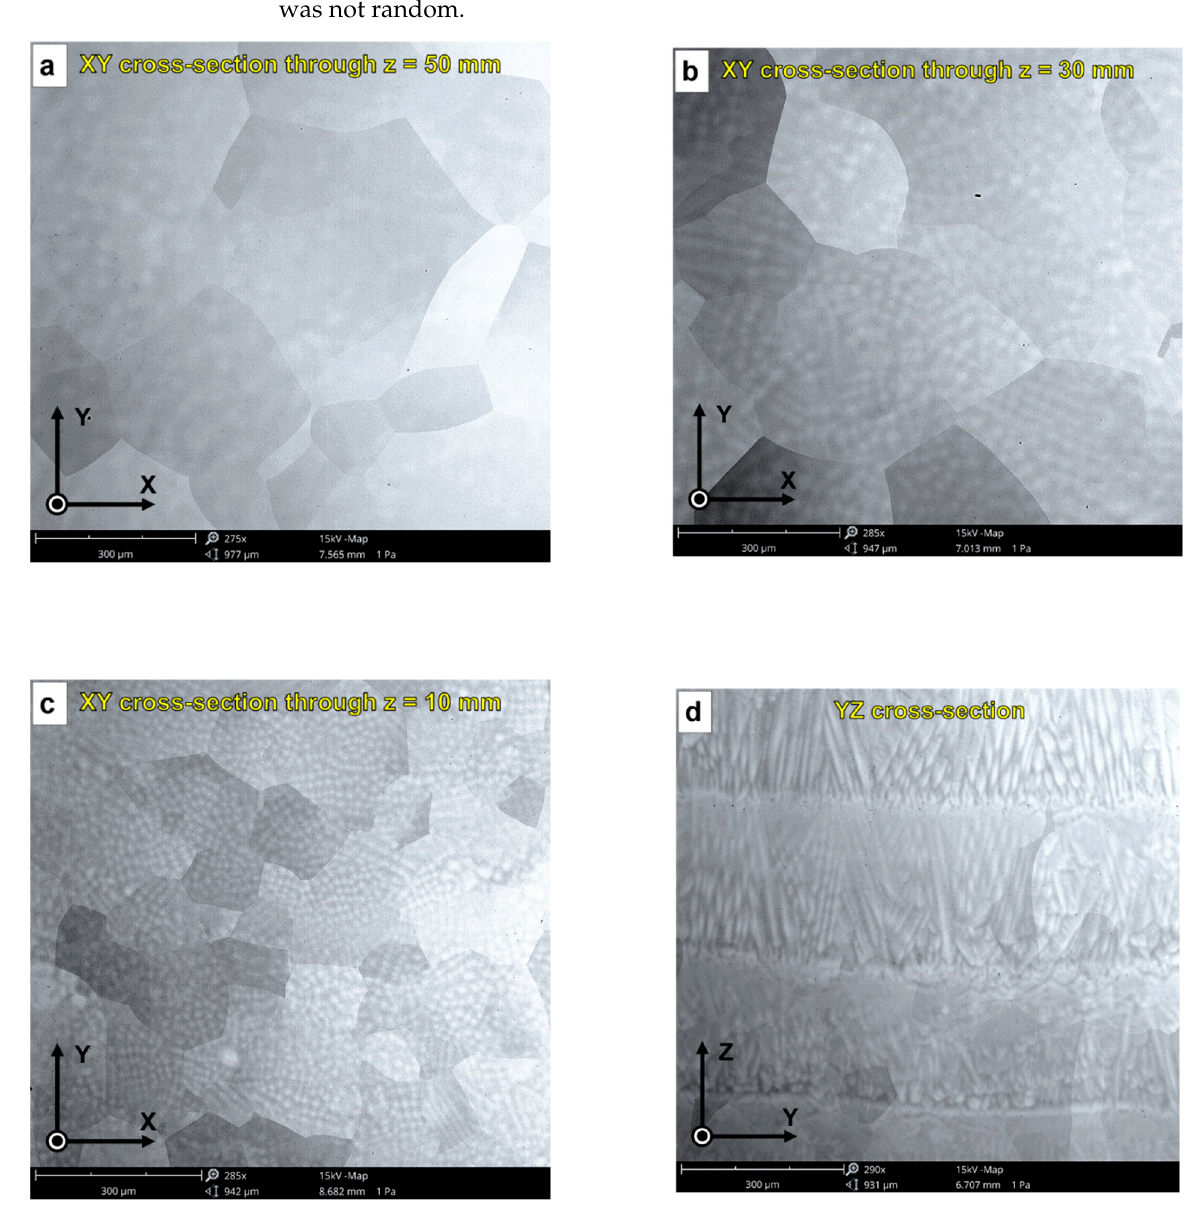
Figure 6. SEM micrographs of laser-deposited Ti-42Nb samples: ( a ) XY cross-section through z = 50 mm, ( b ) XY cross-section through z = 30 mm, ( c ) XY cross-section through z = 10 mm, and ( d ) YZ cross-section.